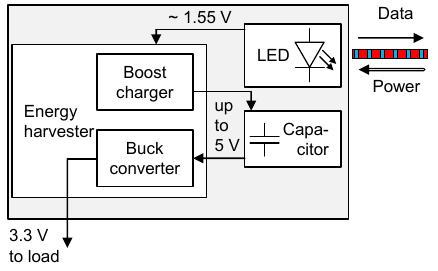
Figure 21. Block diagram of the energy harvester consisting of the energy harvester chip, the LED and the capacitor.